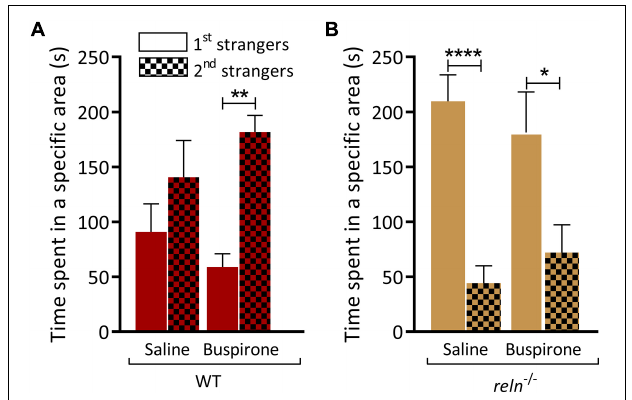
FIGURE 7 | Buspirone increase the social preference for novelty in WT but not reln − / − . (A) WT treated with saline spend equal time near the two groups of unfamiliar fish, whereas WT treated with buspirone switch preference and spend more time near the new group of unfamiliar fish. (B) Buspirone treatment does not completely rescue the impaired preference for social novelty of reln − / − zebrafish (WT with saline p = 0.51; WT with buspirone p = 0.0039; reln − / − with saline p < 0.0001; reln − / − with buspirone p = 0.012). Three-way ANOVA followed by Sidak’s post hoc , genotype factor: F (1,56) = 0.2488, p = 0.62, stranger factor: F (1,56) = 2.11, p = 0.16, treatment factor: F (1,56) = 0.0124, p = 0.91, interaction genotype × stranger: F (1,56) = 40.28, p < 0.0001, interaction genotype × treatment: F (1,56) = 0.01879, p = 0.89, interaction stranger × treatment: F (1,56) = 3.362, p = 0.07, interaction stranger × genotype × treatment: F (1,56) = 0.0566, p = 0.81). n = 8 WT and n = 8 reln − / − . ∗ p < 0.05, ∗∗ p < 0.01, ∗∗∗∗ p < 0.0001. Mean ± SEM.